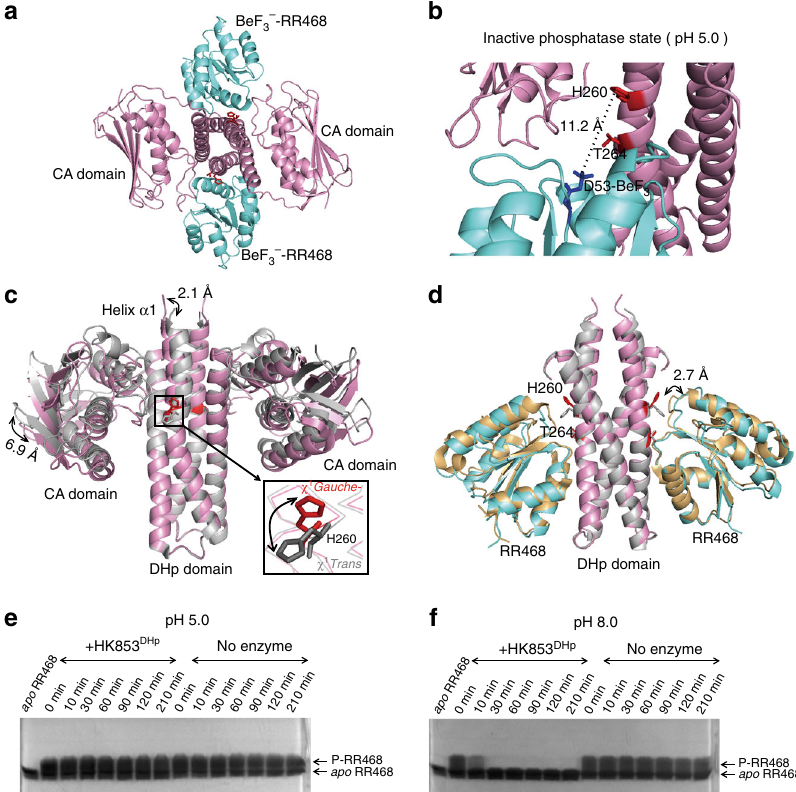
Fig. 2 Crystal structure of the HK853 cp -BeF 3 − -RR468 complex at low pH reveals a catalytically inactive state. a The structure of the HK853 cp -BeF 3 − -RR468 complex at pH 5.0. The BeF 3 − -RR468 substrate is shown in cyan, the HK853 cp dimer in pink, and the sidechains of H260 and T264 of HK853 cp in red. b Structural details of the inactive state of the HK853 cp -BeF 3 − -RR468 complex at pH 5.0. The BeF 3 − -D53 residue of RR468 is shown in blue, and the distance between the ε -N atom of H260 and the Be atom is labeled. c A pH-gated conformational switch of HK853 cp . Superimposed structures of the inactive state (pink, with the sidechain of H260 in red; this structure) and active state (gray, PDB 3DGE) of the HK853 cp -BeF 3 − -RR468 complex demonstrate the sidechain fl ipping of H260 and the movements of the CA domain and the N-terminal α 1-helix of the DHp domain. The distances between C α atoms of C359 of the CA domain and between C α atoms of R246 of the DHp domain in the two structures are labeled. For visual clarity, RR468 is not displayed. The − -RR468 complex between the inactive χ 1 rotameric states of H260 in the two structures are labeled. d Structural movement of RR468 in the HK853 cp -BeF 3 state (with RR468 shown in cyan) and active state (with RR468 shown in orange). The distance between C α atoms of G87 in the two structures is labeled. For visual clarity, the CA domains are not displayed. Structural overlays in c , d are generated by superimposing the α 2-helix and the C-terminal half of the α 1-helix (residues of 266 – 317) of the DHp domain of HK853 cp . e , f show the differential phosphatase activities of HK853 DHp detected by the Phos-tag gel shift assay at pH 5.0 and pH 8.0,